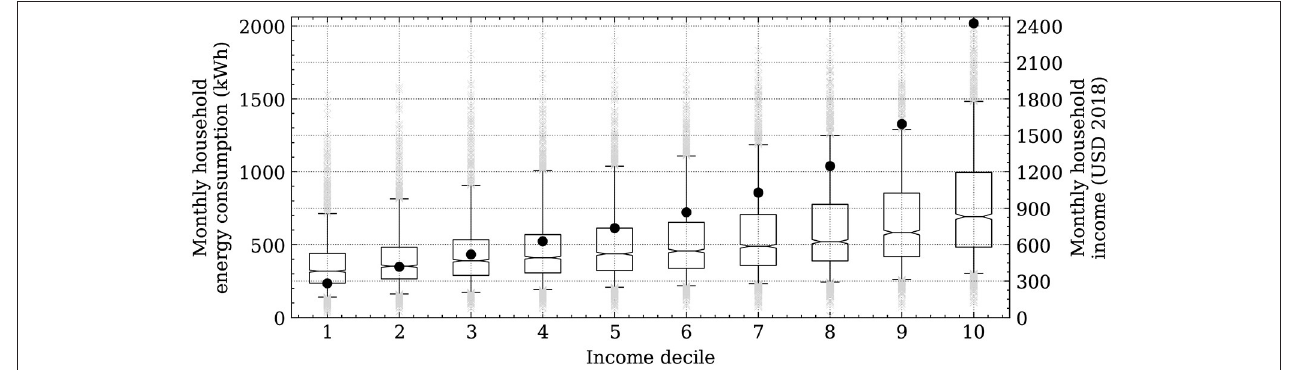
FIGURE 4 | Monthly energy consumption (boxplots) and median income (dots) for Mexican households by income decile.